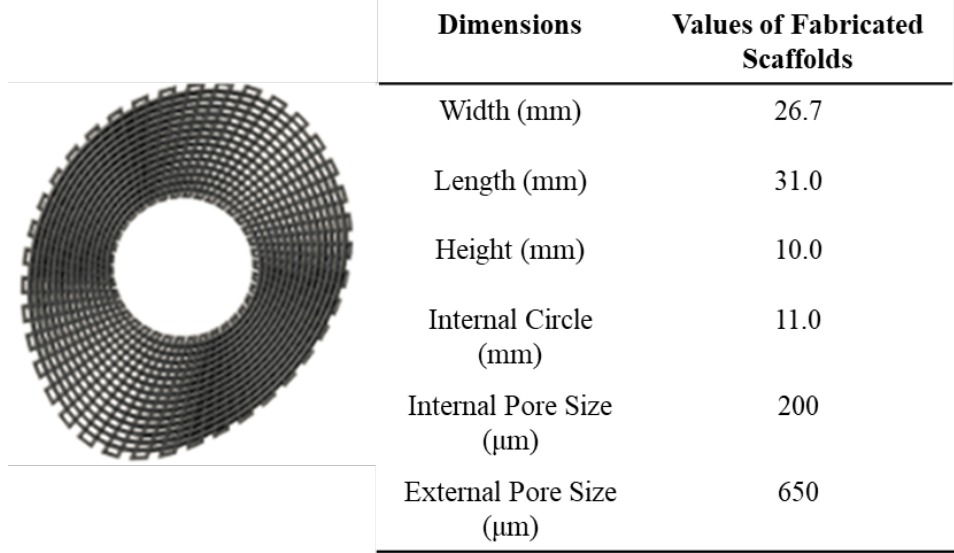
Figure 2. The anthropometric-based geometry and scaffolds dimensions.